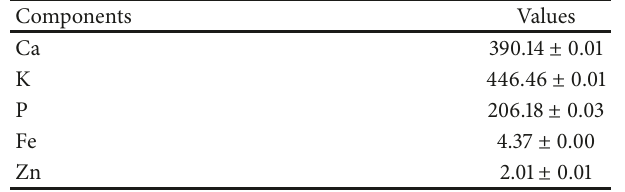
Table 2: Mineral contents of cactus pear seed (mg/100g, dry basis).